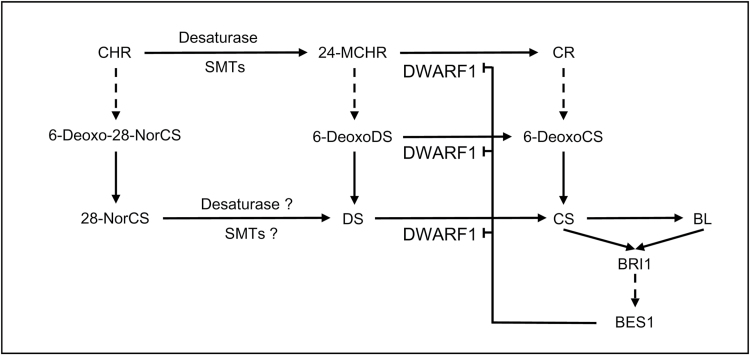
Connections of three BR biosynthetic pathways that function in Arabidopsis. Three biosynthetic pathways are funneled into CS. DWF1 is feedback-regulated through BR signaling via a transcription factor, BES1, in the plant. Solid arrows indicate a single biosynthetic step. Dotted arrows indicate multiple biosynthetic steps. SMT, sterol methyltransferase.